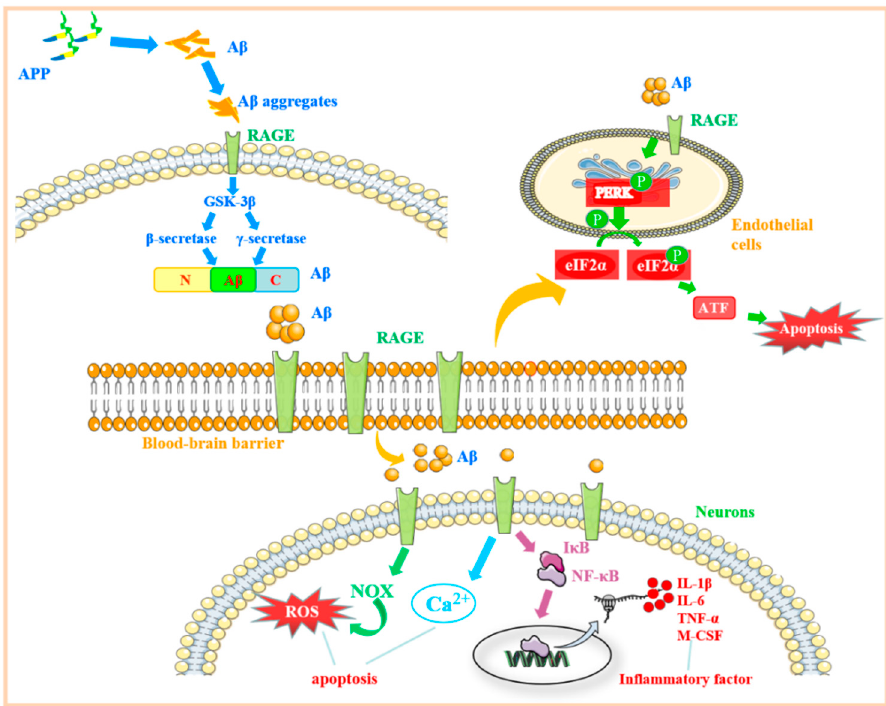
Figure 4. RAGE-related signaling pathways in Alzheimer’s disease. After APP is converted to A β , on the one hand, it combines with RAGE to activate the downstream MAPK/NF- κ B pathway to release inflammatory factors and damages nerve cells. On the other hand, A β binds to RAGE on the surface of BBB cells, causing ERS, altering the permeability of the BBB, increasing the concentration of A β in the central nervous system, and aggravating AD-related symptoms. Abbreviations: APP: amyloid prebiotic protein; A β : amyloid β -protein; RAGE: receptor for advanced glycation end prod-